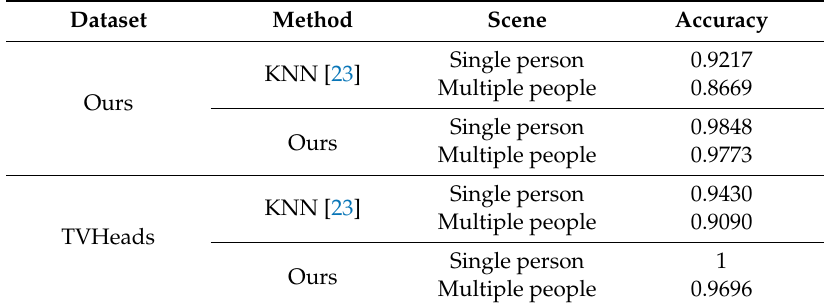
Table 7. Performance comparison of different flow estimation methods on the TVHeads dataset and our proposed dataset,